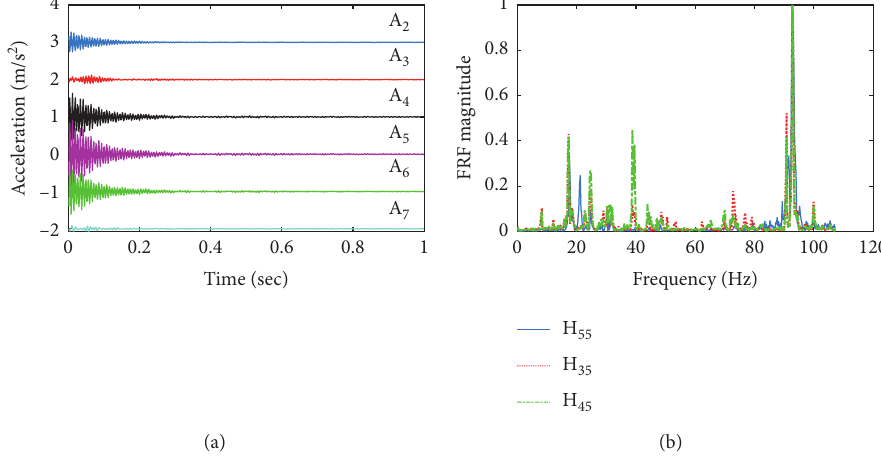
Figure 10: (a) Acceleration measurements after impact at A5 location on the beam. (b) FRF of the measured accelerations (undamaged state).